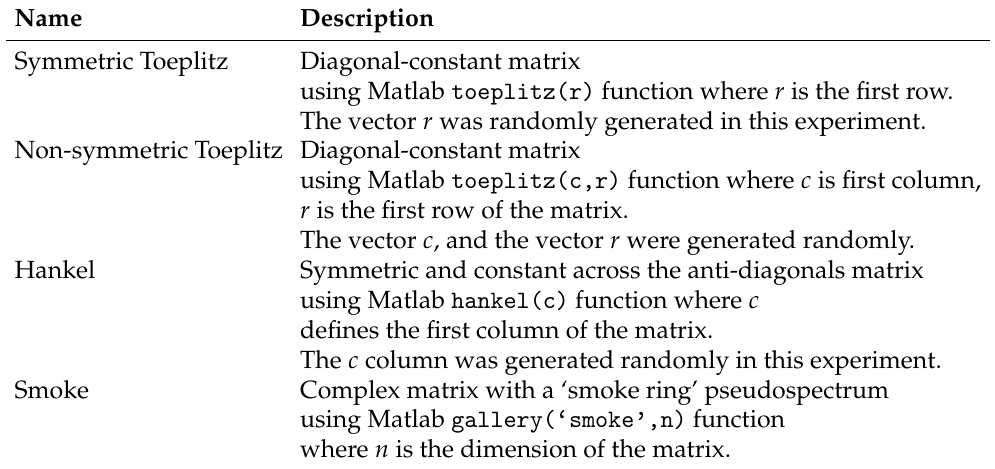
Table 1. Summary of test problems chosen from MATLAB